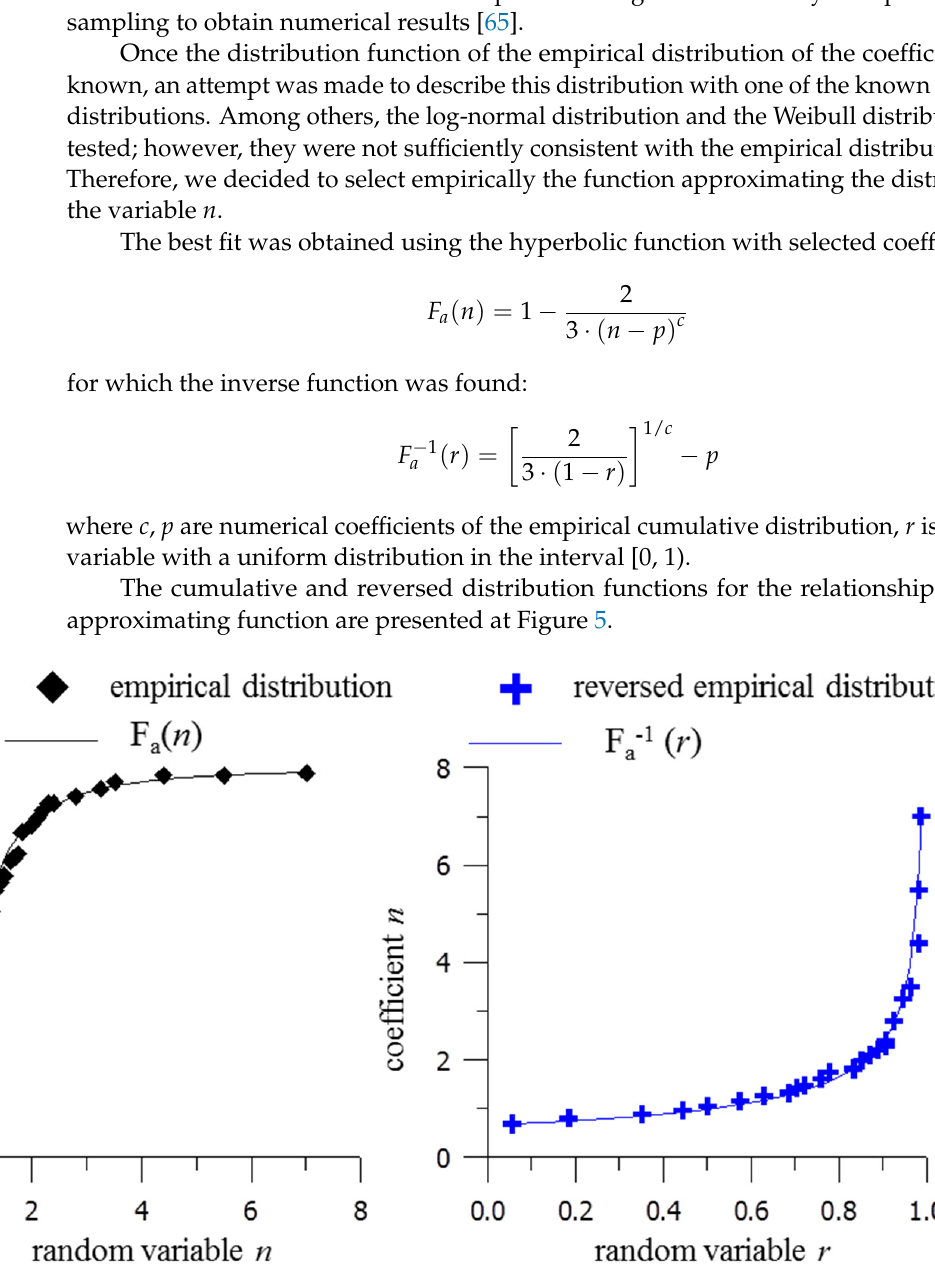
Figure 5. Cumulative and inversed distribution function of the n coefficient and functions approximating these distributions.